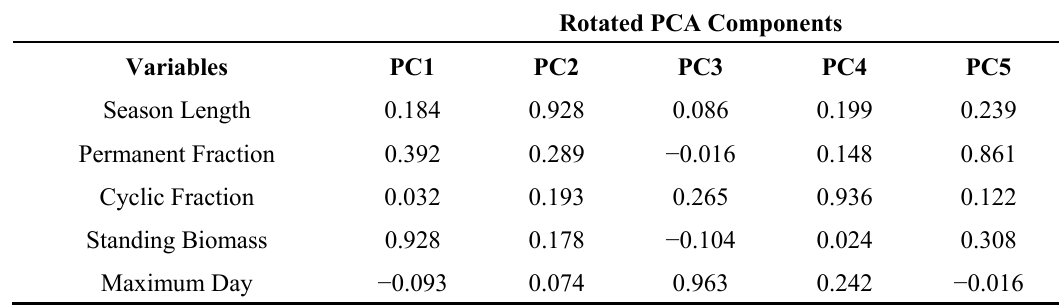
Table 3. Normalized loadings of the selected phenological variables on the first five rotated axes of the final PCA